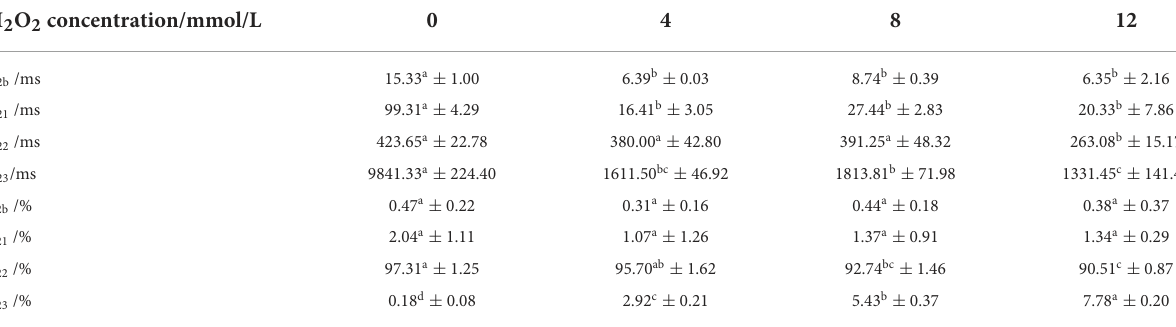
TABLE 1 Changes in peak relaxation times and the ratio of peak areas of water molecules in duck myofibrillar proteins (DMPs) gels pretreated with various hydroxyl radicals levels (H 2 O 2 concentrations: 0, 4, 8, 12